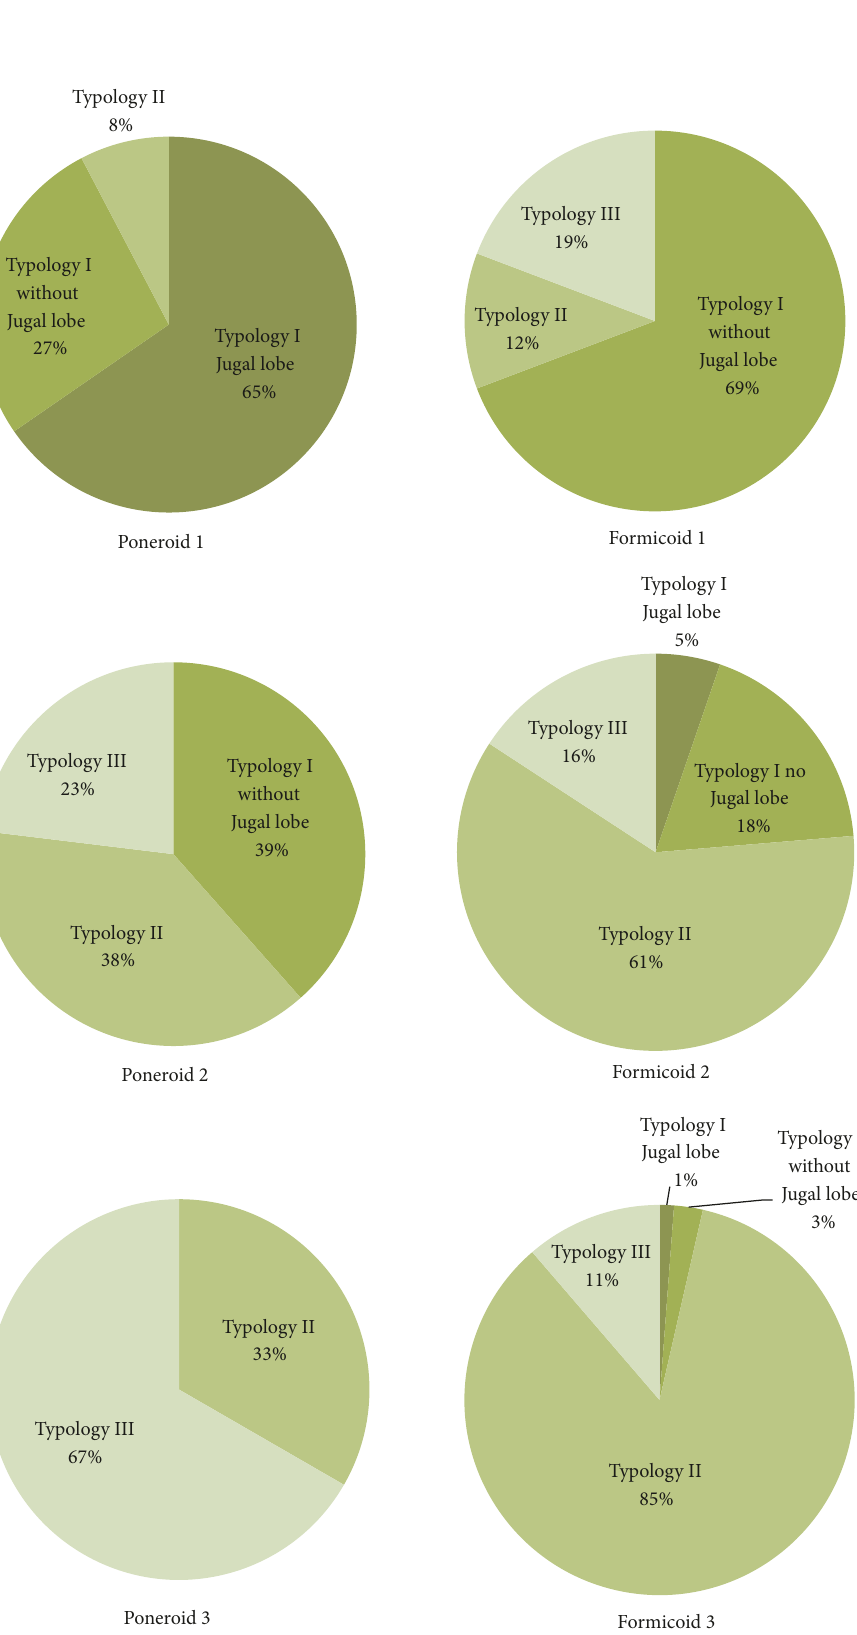
Figure 8: Percentages related to genera, for each hindwings Typology, in six Subclades of the Family